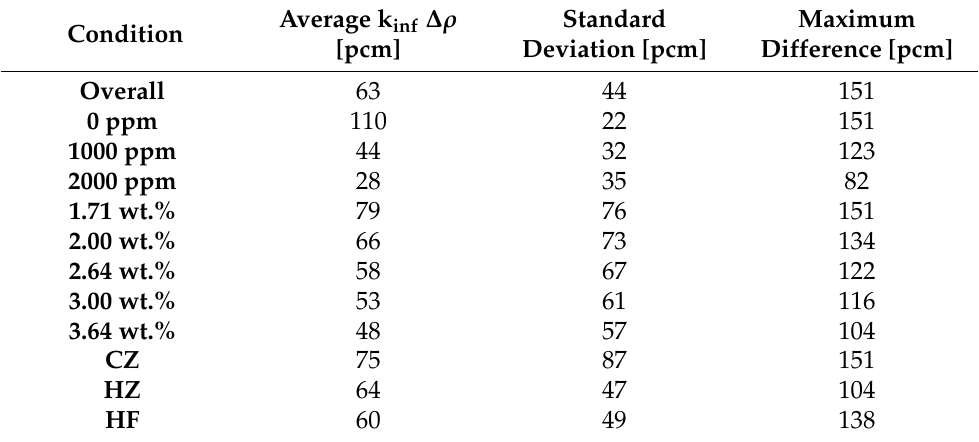
Table 2. Average reactivity difference, standard deviation, and maximum difference for various groups of single fuel pin cases.